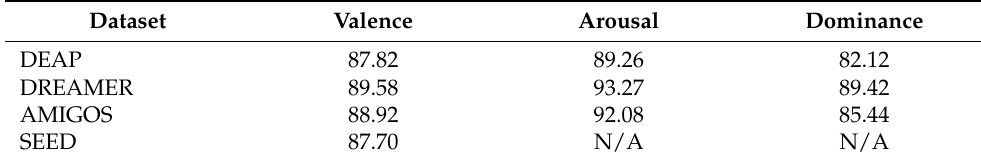
Table 9. Accuracy for female subjects with the channels selected with the ReliefF.